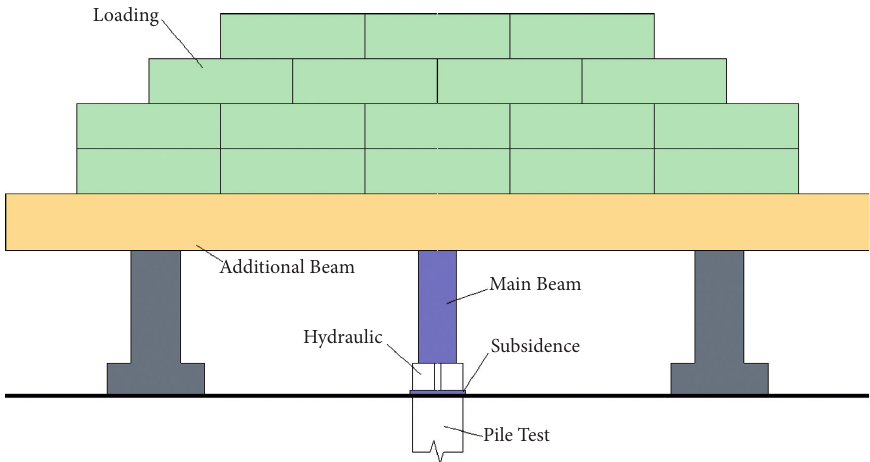
Figure 1: Static load test experiment for measuring pile bearing capacity.